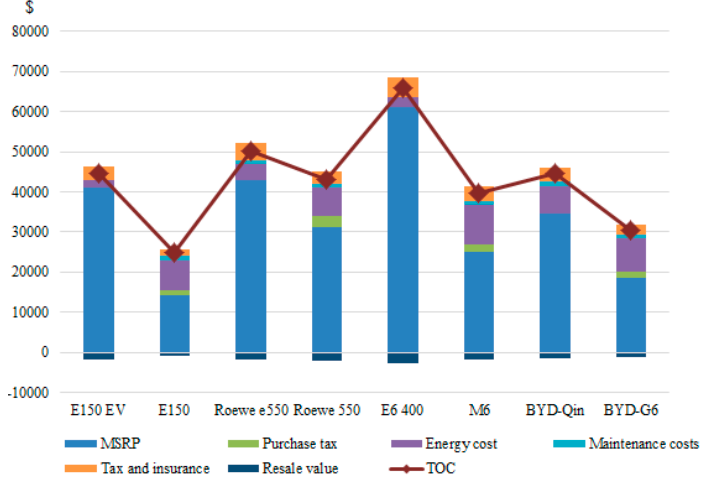
Figure 4. The TOCs for conventional vehicles, battery vehicles, and plug-in hybrid gasoline-electric vehicles (without government subsidy).